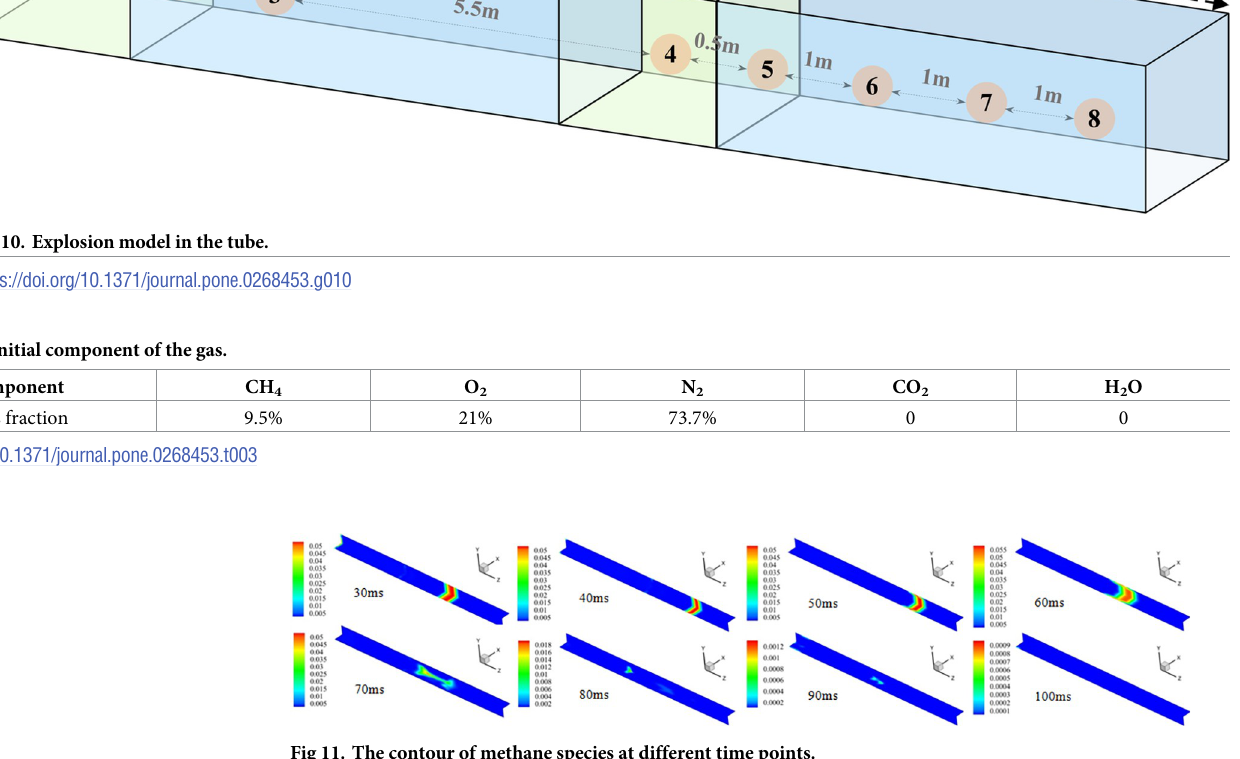
Fig 11. The contour of methane species at different time